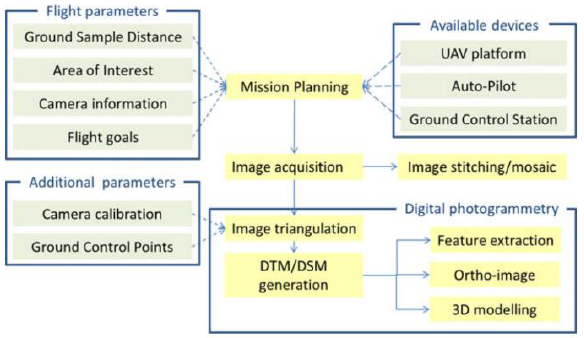
Figure 2. Interdependence of different steps in capturing procedure, after [Nex and Remondino, 2014].